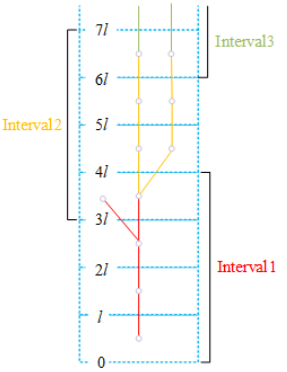
Figure 6. Each interval contains one more